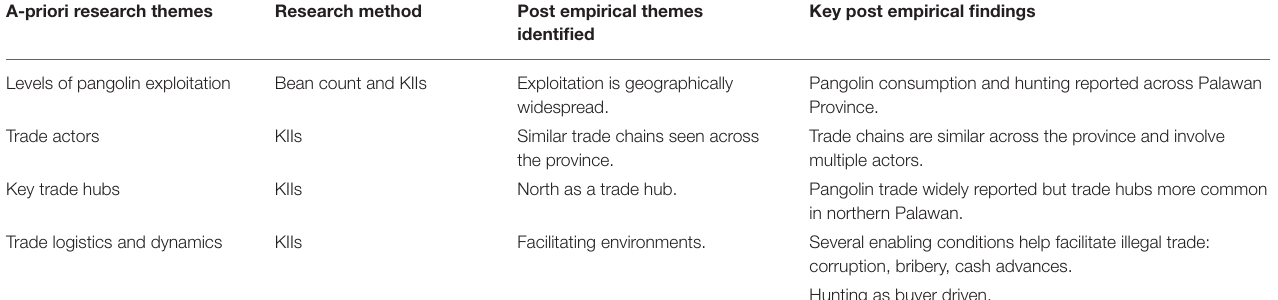
TABLE 2 | A-priori and post empirical research themes.